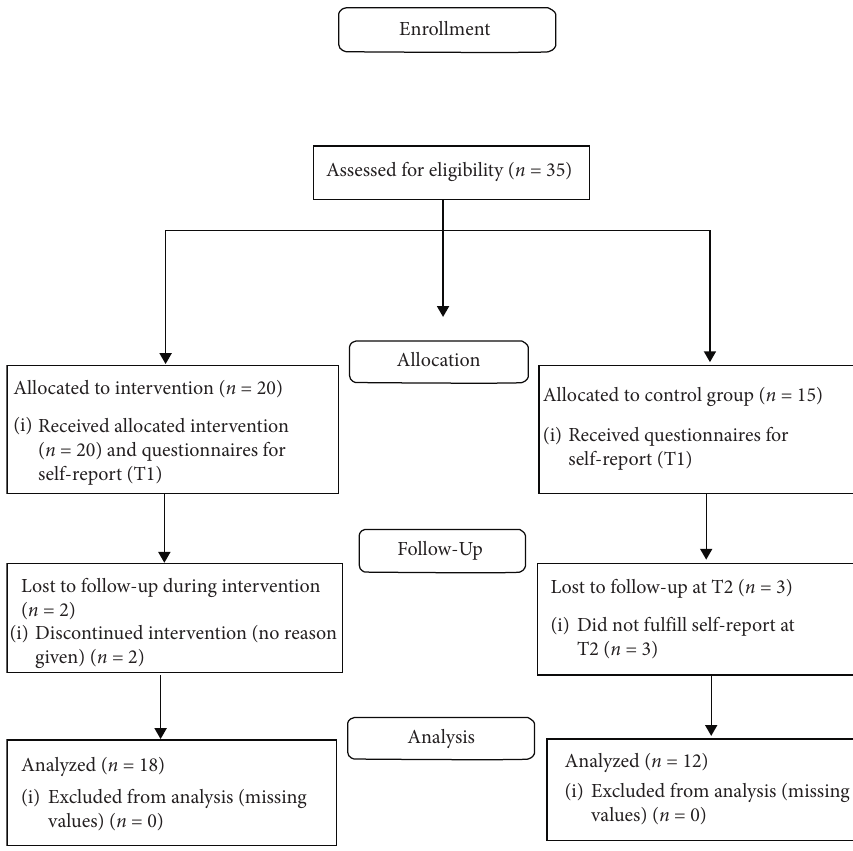
Figure 1: Flow diagram of the participants in the intervention and control